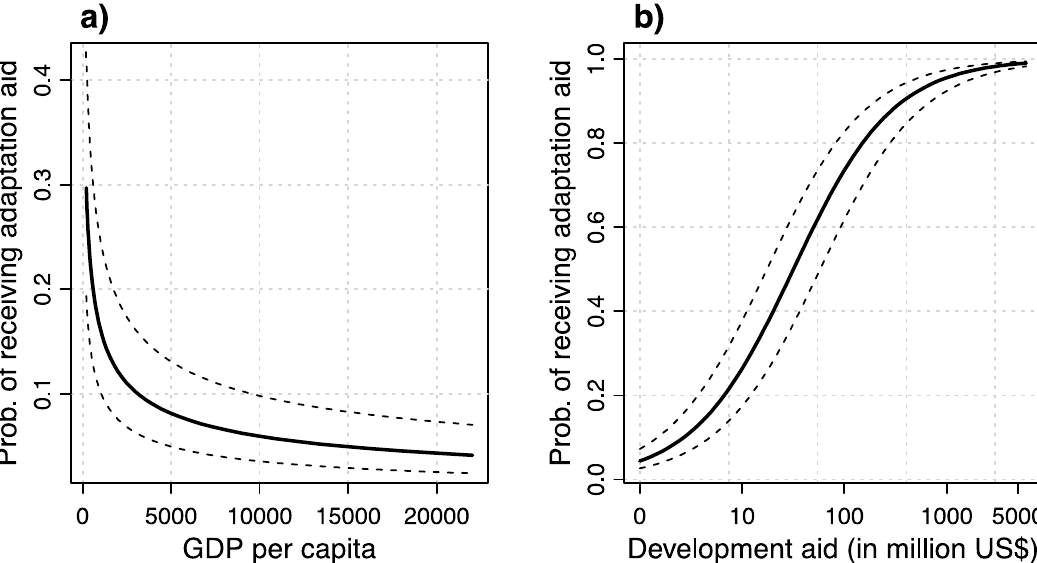
Figure 3. This figure shows the effects of GDP per capita ( a ) and development aid ( b ) on the likelihood of receiving adaptation aid. The figures also show 90% confidence intervals.